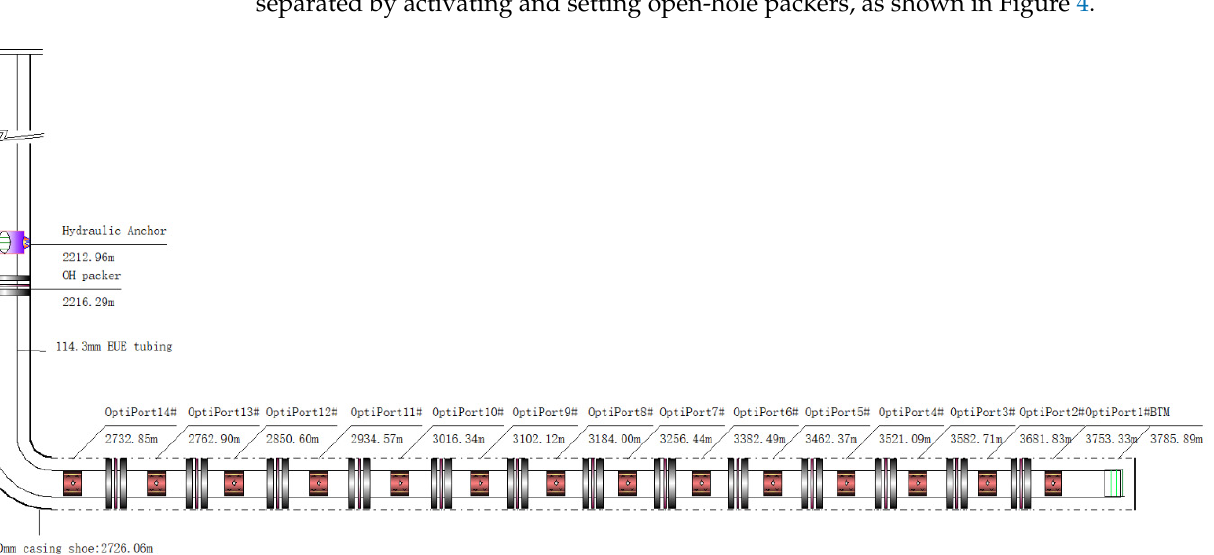
Figure 4. Schematic of open-hole packer and infinite sliding sleeve multistage fracturing completion